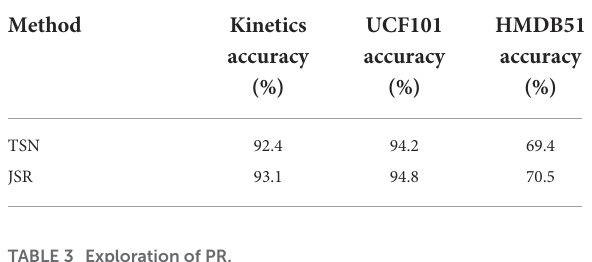
TABLE 6 Kinetics top-1 and top-5 accuracy